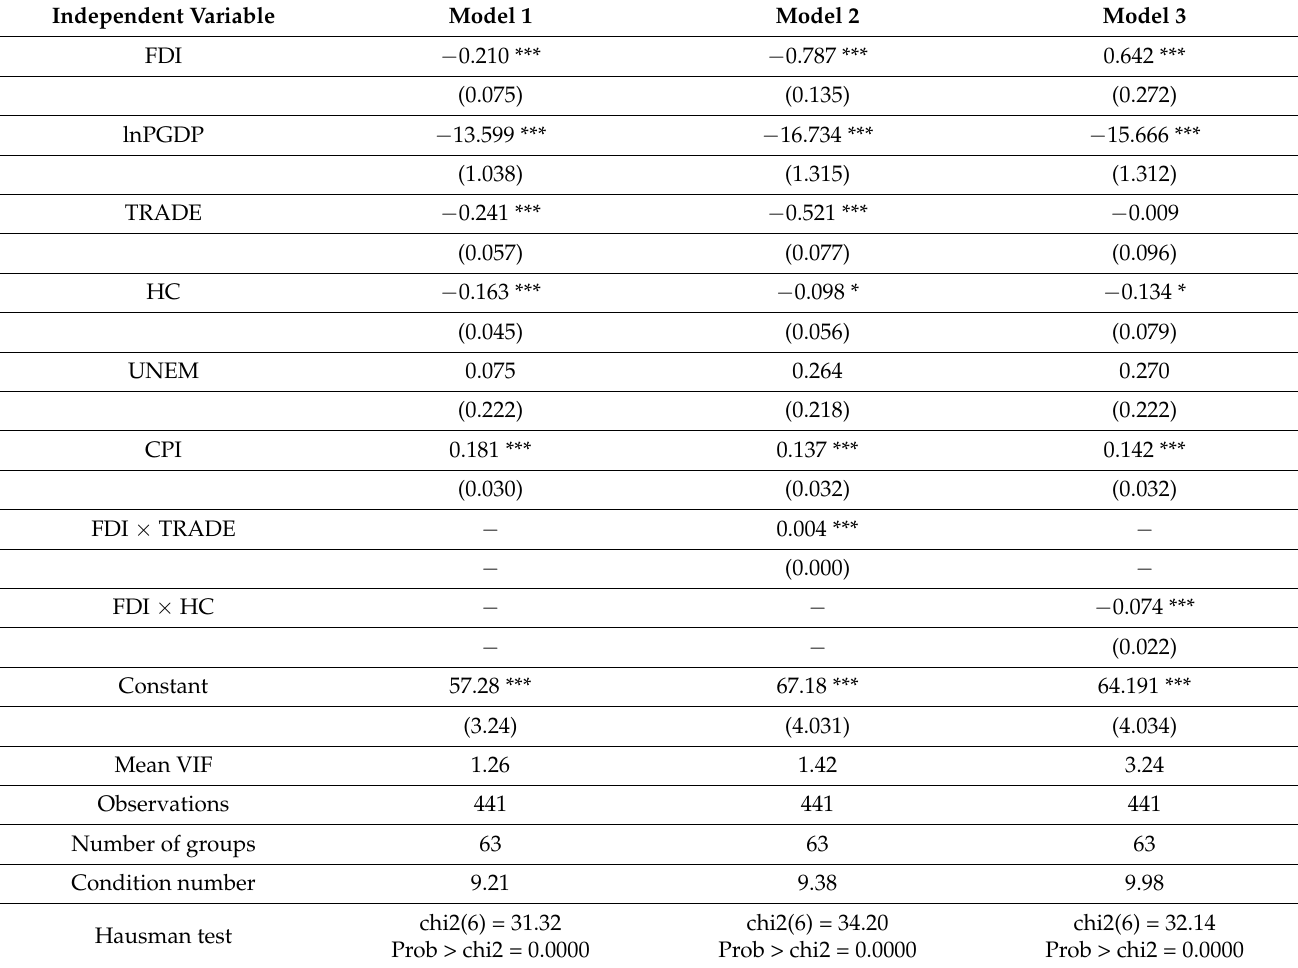
Table 3. Fixed-effect regression estimation